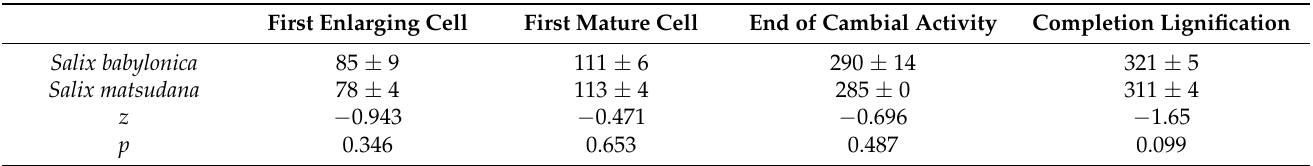
Table 1. Xylem differentiation of Salix babylonica and Salix matsudana .